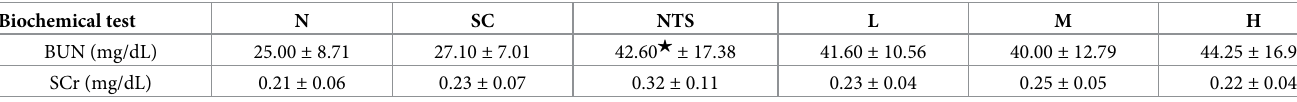
Table 1. BUN and serum creatinine (SCr) levels of each experimental group. Biochemical test